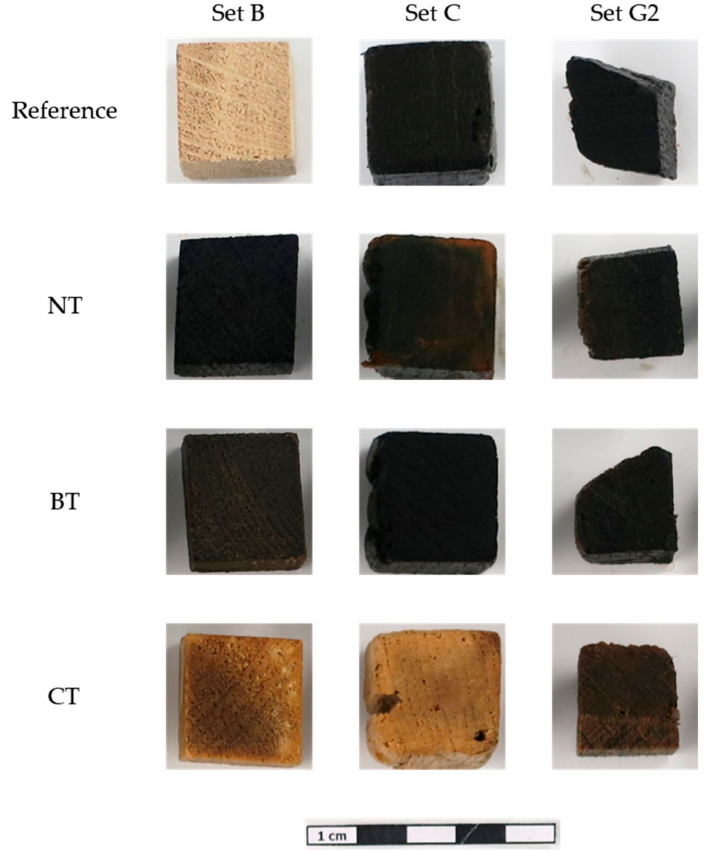
Figure 1. Appearance of reference, untreated (NT), biologically treated (BT) and chemically treated (CT) samples for sets B, C and G2 (fresh and archaeological artificially contaminated and archeological oak wood,